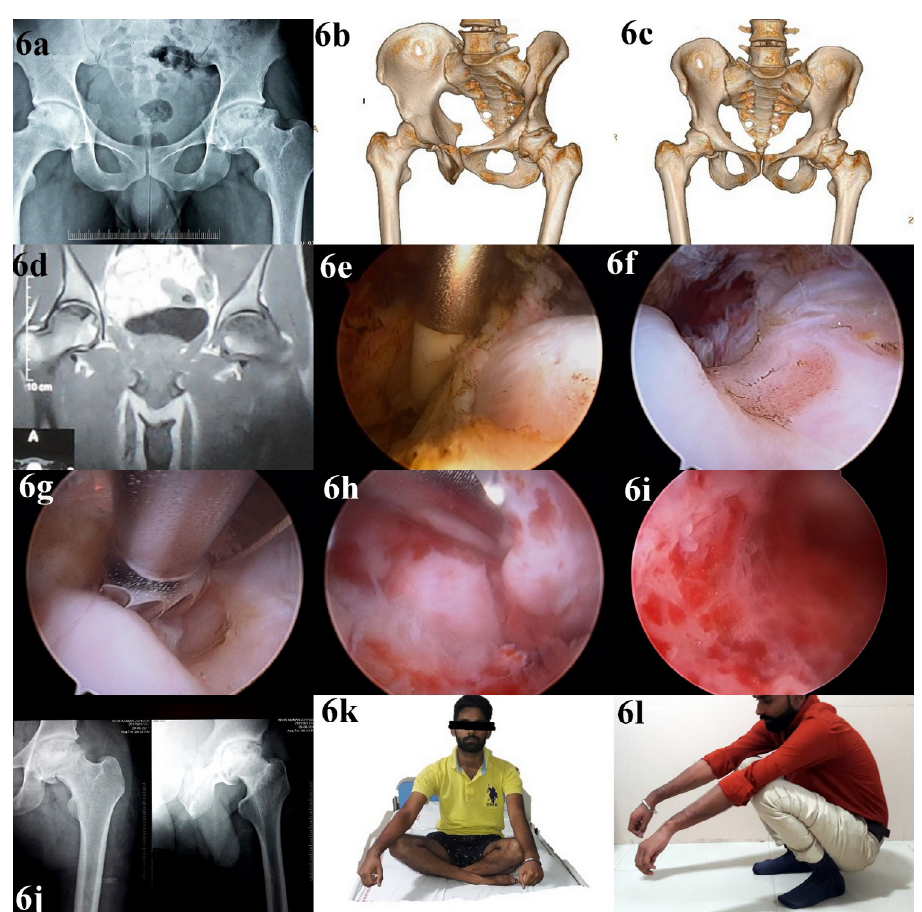
Figure 6. Follow-up of a 33-year-old male presenting with symptoms of hip impingement after alcohol-induced ONFH; panel a: preoperative radiograph showing cam deformity in right femoral head; panels b and c: preoperative CT scan showing extent and location of cam deformity in the femoral head; panel d: MRI of the hip joint done 1.8 years before the surgery con fi rming ONFH bilaterally; panel e: intraoperative image showing arthroscopy of the peripheral compartment of the hip joint using outside-in capsulotomy; panel f: intraoperative image of hip arthroscopy showing identi fi cation of the cam deformity; panel g: intraoperative image of hip arthroscopy showing resection of the cam deformity; panel h: intraoperative image of hip arthroscopy showing cam deformity in the anterolateral part of femoral neck; panel i: intraoperative image of hip arthroscopy after removal of the deformity; panel j: post-operative radiograph after removal of cam deformity; panels k and l: post-operative follow-up images showing restoration of hip range of